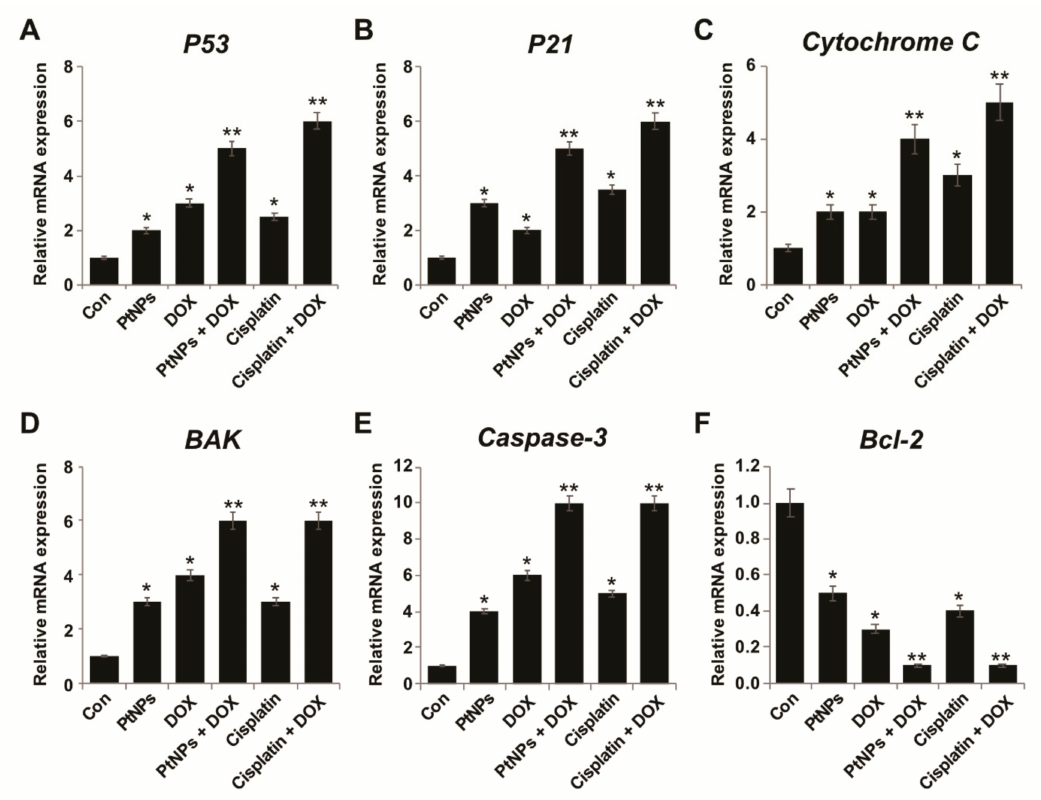
Figure 12. E ff ect of PtNPs and DOX on expression of pro and antiapoptotic genes ( A – F ). U2OS cells were treated with PtNPs (10 µ g / mL), DOX (1 µ g / mL), CIS (5 µ g / mL), or a combination of PtNPs (10 µ g / mL) and DOX (1 µ g / mL) or combination of DOX (1 µ g / mL) and CIS (5 µ g / mL) for 24 h and their relative mRNA expression of apoptotic and antiapoptotic genes was analyzed by quantitative RT-PCR. Expression was determined as the fold change compared to GAPDH expression. Di ff erences between the treated and control groups were measured using Student’s t -test and statistically significant di ff erences are indicated by * ( p < 0.05). The results are presented as mean ± standard deviation of three experiments. * p < 0.05 was considered significant; ** p < 0.01 was considered highly significant and *** p < 0.001 was considered very highly